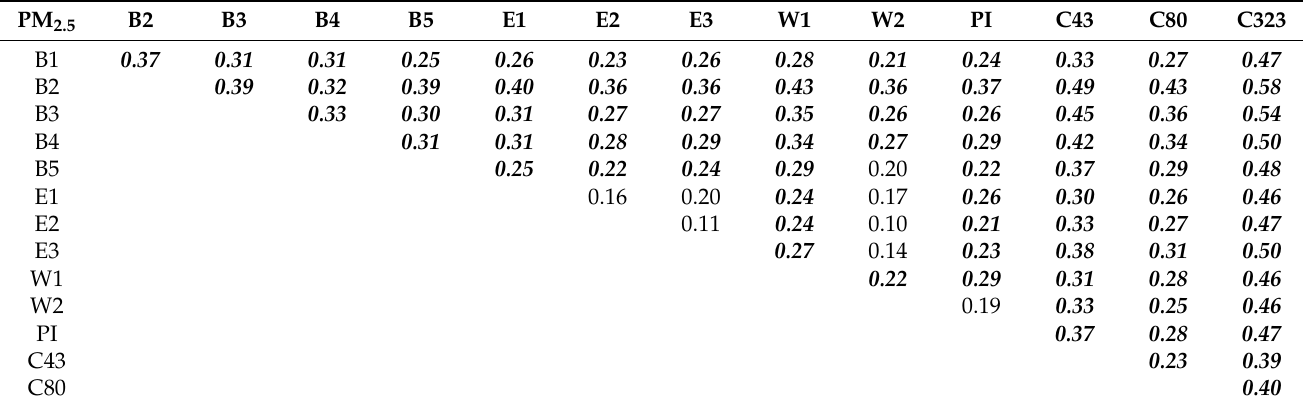
Table 5. COD values from LCSs and TCEQ CAMSs with spatial heterogeneity are identified in bold